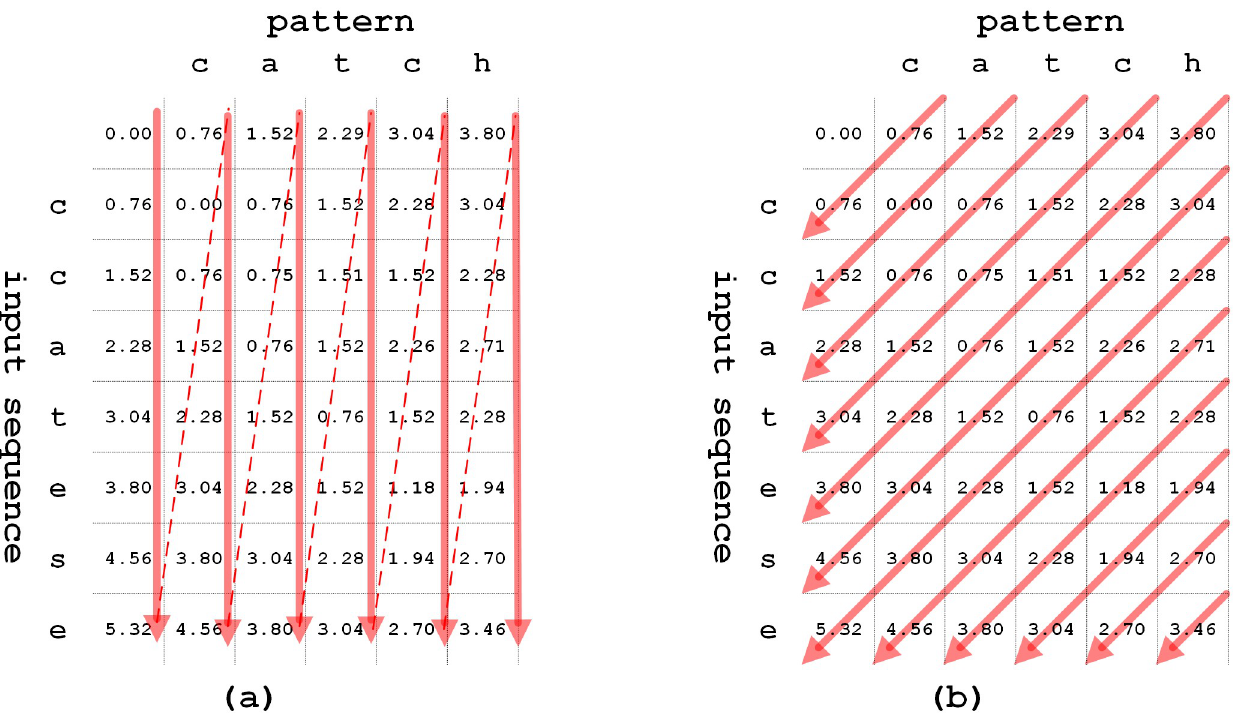
Fig 4. Step calculations in edit distance matrix; (a) vertical traversals: (b) diagonal traversals.